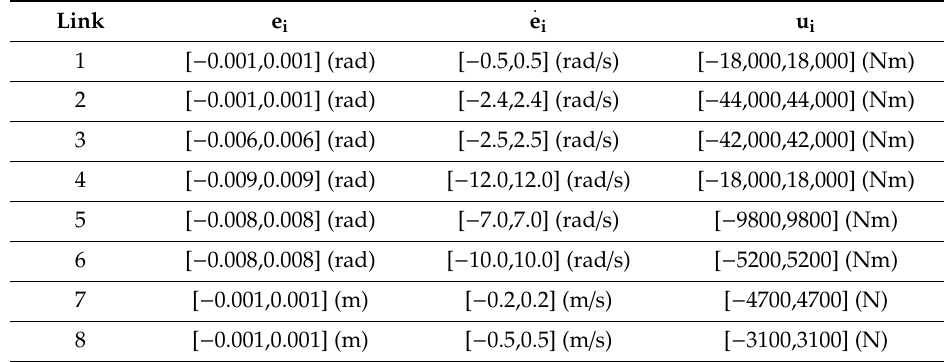
Table 6. The physical value domain of input and output quantities of the fuzzy controller.